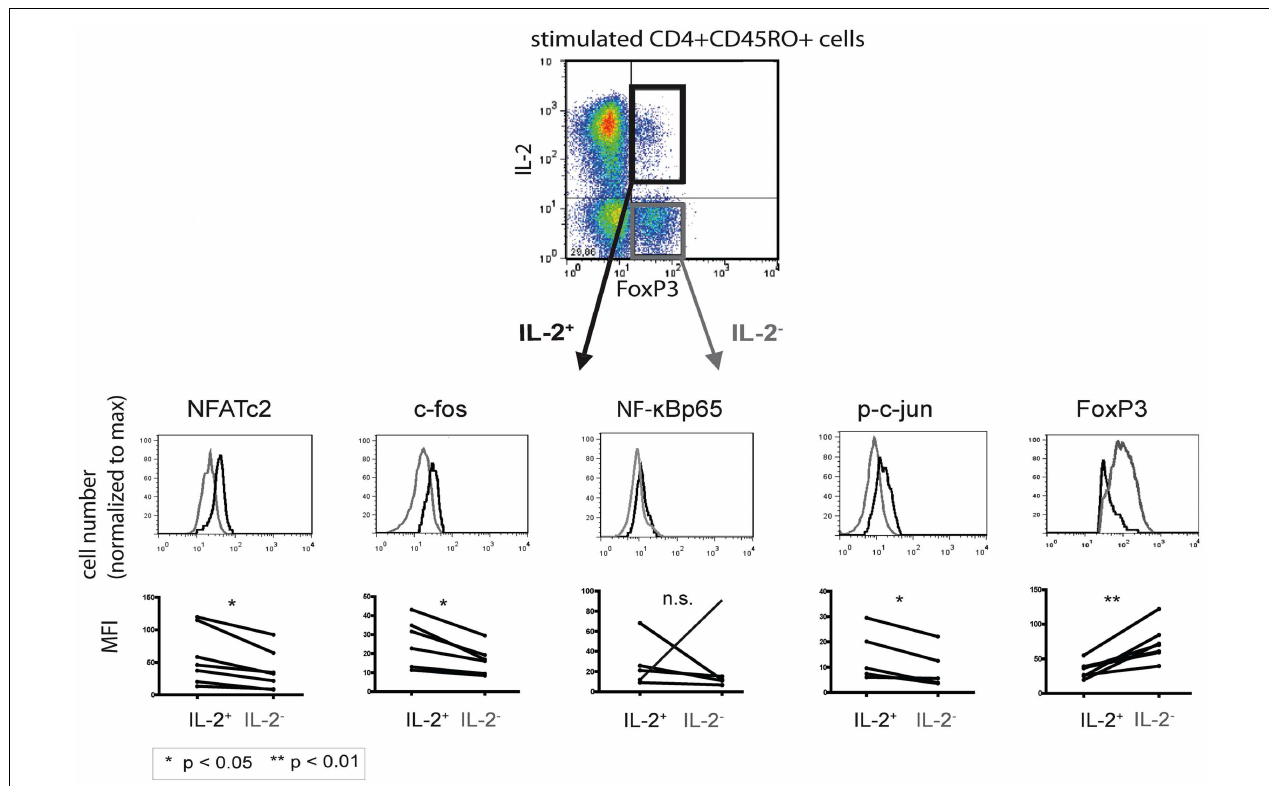
overlays of the transcription factor expression in the two subpopulations of one representative donor ( n = 5 or 6). Differences in the mean fluorescence intensity (MFI) of the transcription factors between IL-2-expressing and -non-expressing FOXP3 + Th cells in five or six different donors are shown as graphs. Significance was determined using a paired student t